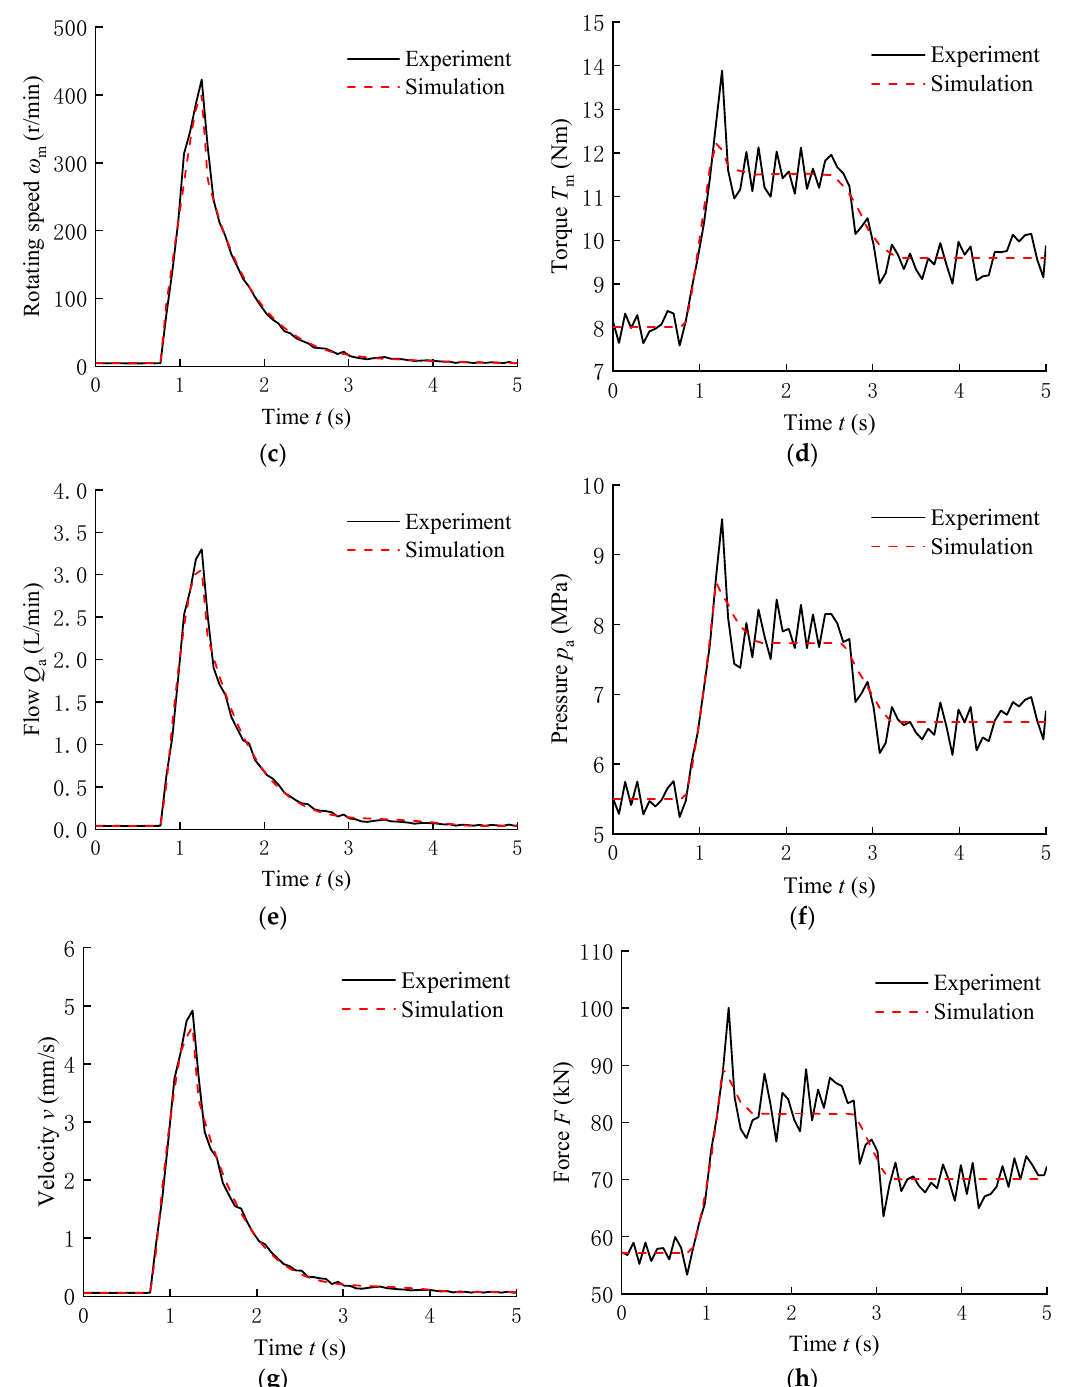
Figure 8. Energy transfer simulation and experimental curves of the EHSPCS: ( a ) Input voltage; ( b ) Input current; ( c ) PMSM speed; ( d ) PMSM torque; ( e ) Flow of fixed displacement pump; ( f ) Pressure of fixed displacement pump; ( g ) Hydraulic cylinder speed; ( h ) Output force of hydraulic cylinder.